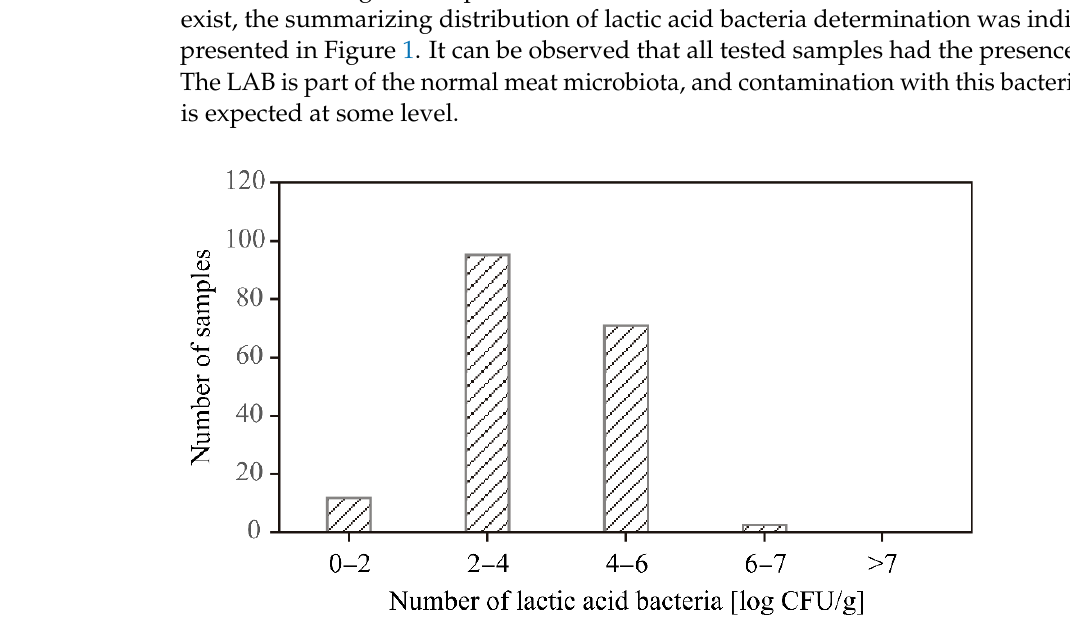
Figure 1. Frequency plot of lactic acid bacteria in minced meat samples.